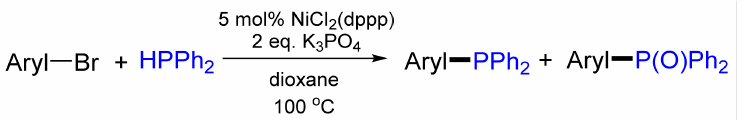
Figure 10. Nickel-catalyzed cross-coupling between aryl bromides and